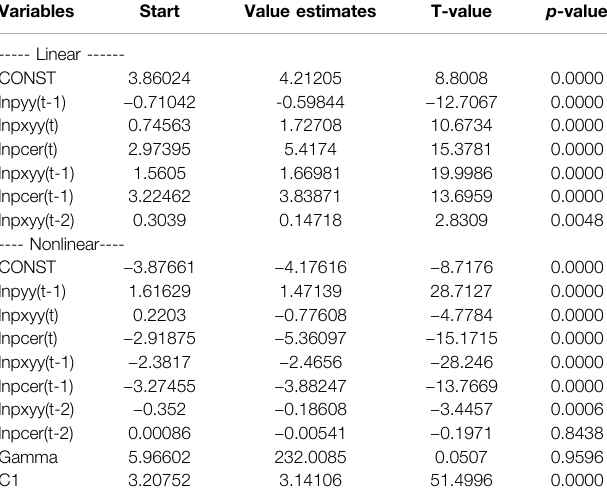
TABLE 5 | Parameter estimation